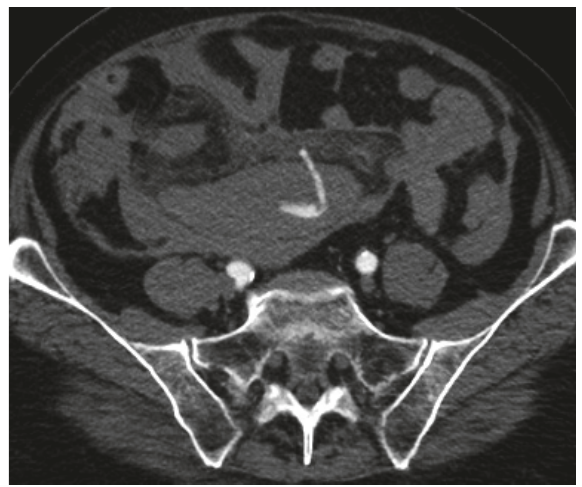
Figure 3: CTA abdomen hyperdense hemorrhaging vessel.